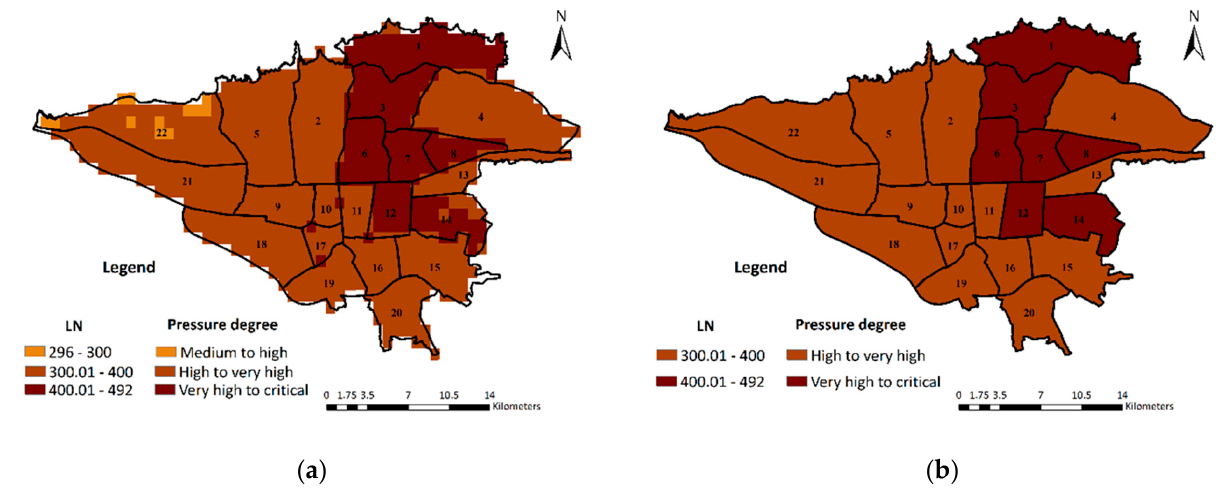
Figure 8. The LN map of human impacts. ( a ) The spatial resolution of 1 km; ( b ) level of 22 districts.